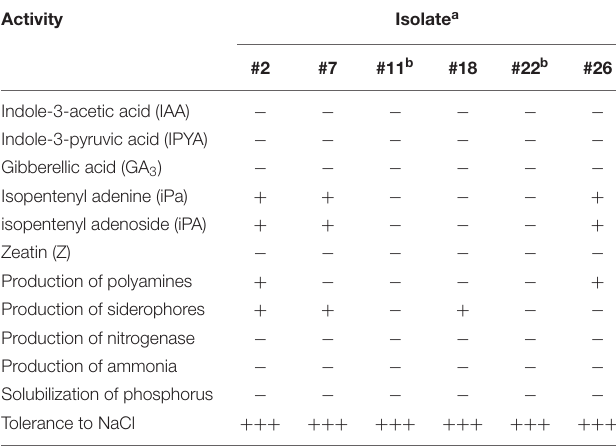
TABLE 3 | In vitro production of plant growth regulators, siderophores, nitrogenase enzyme, and ammonia, and the ability for phosphorus solubilization and tolerance to NaCl, by the five ACC deaminase-producing actinobacteria isolated from Salicornia bigelovii roots. Activity Isolate